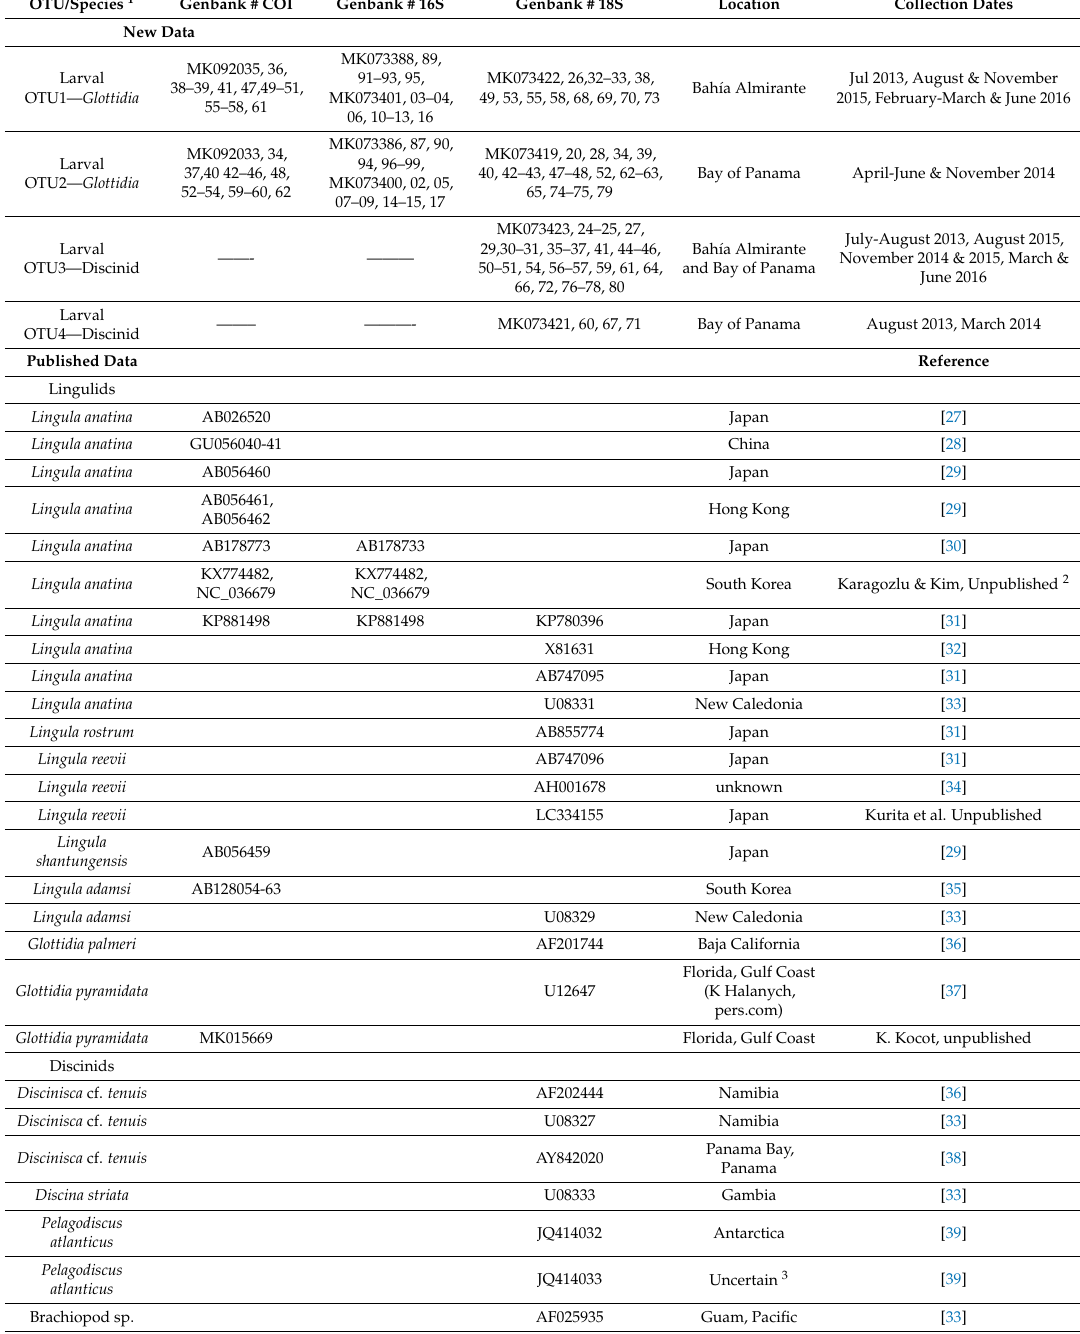
Table 2. Summary of OTUs and GenBank sequences used in this